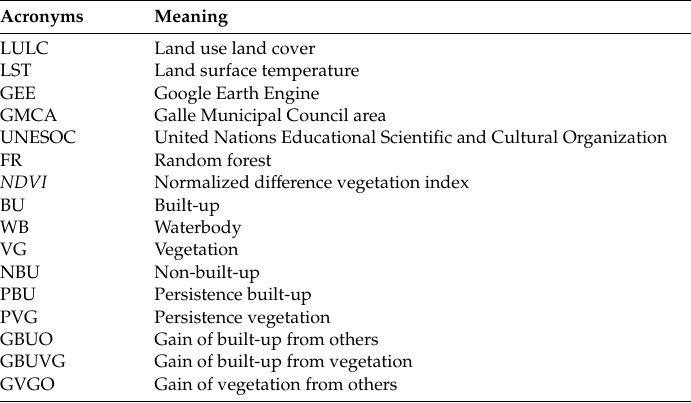
Table A1. Abbreviations are used in this manuscript.